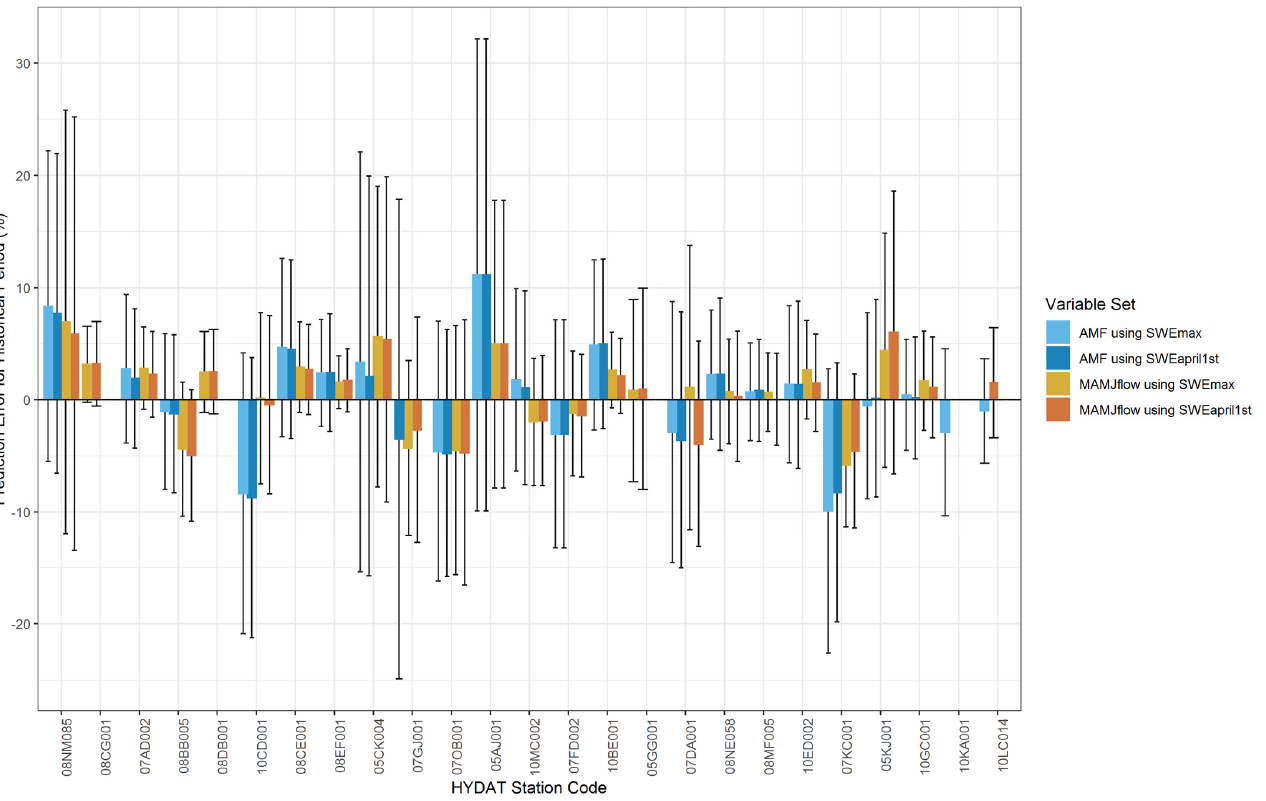
Figure 3. Mean percentage differences between MLR model-predicted and observed annual maximum flow (AMF) and mean spring flow (MAMJflow) over the 1980–2012 period. Error bars indicate the 95% confidence interval for predicted values.